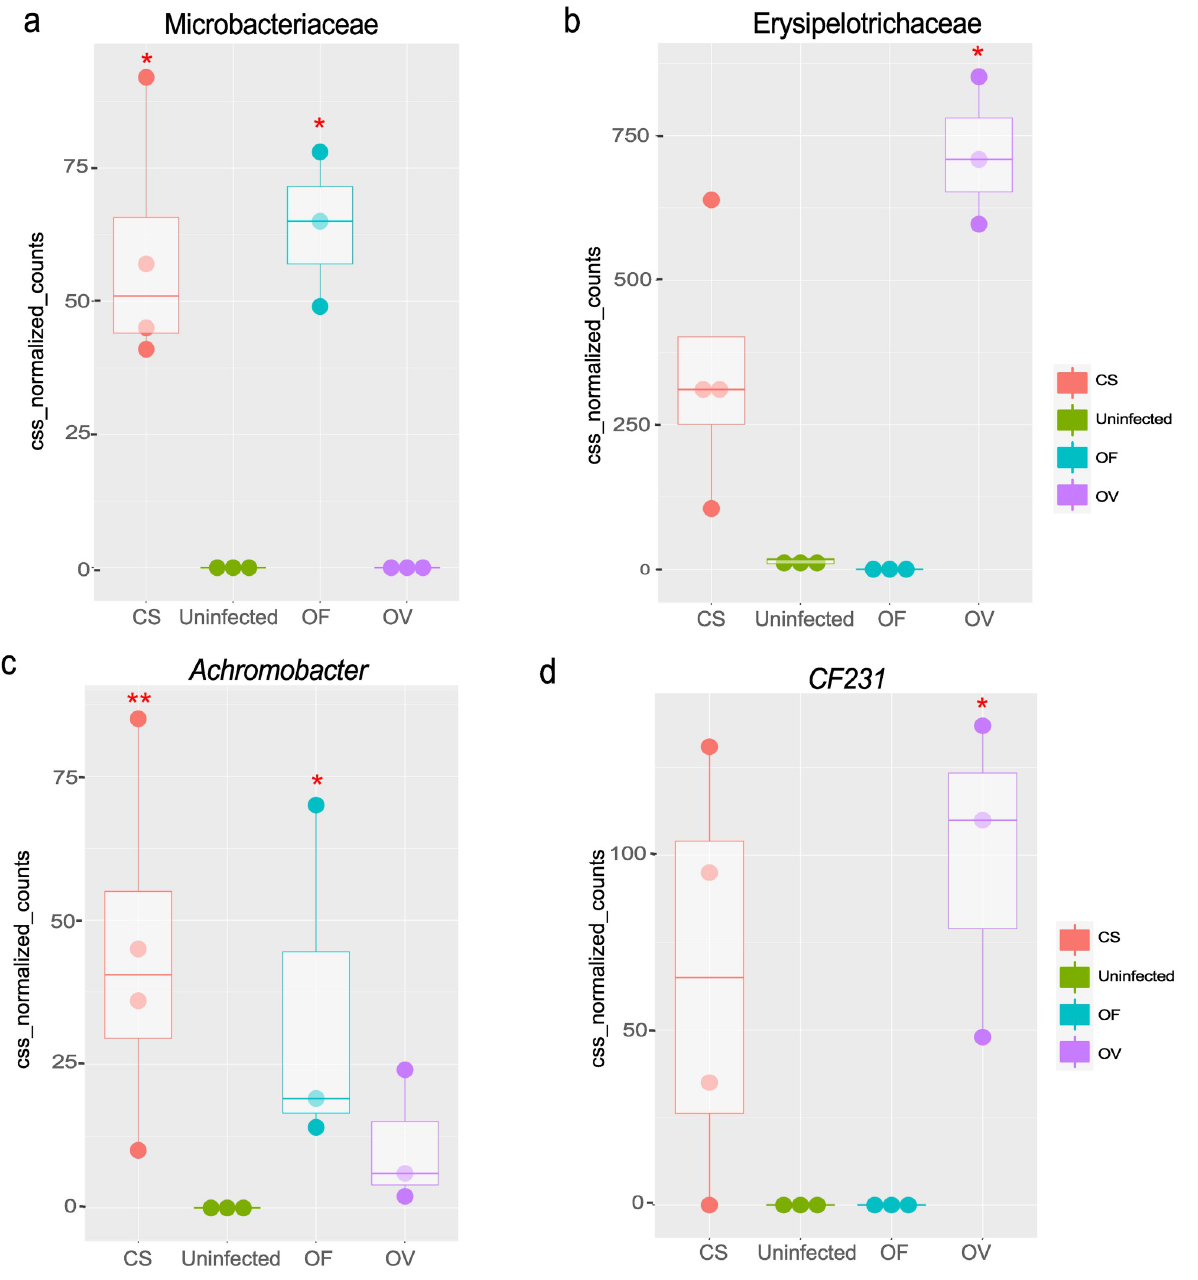
Fig 5. Differently distributed taxa among bile samples. Kruskal Wallis test followed by post-hoc Dunn’s test of CSS-normalized counts with the Bonferroni correction. � P adj < 0.05 as compared to uninfected animals. OF: O . felineus , CS: C . sinensis , OV: O . viverrini .